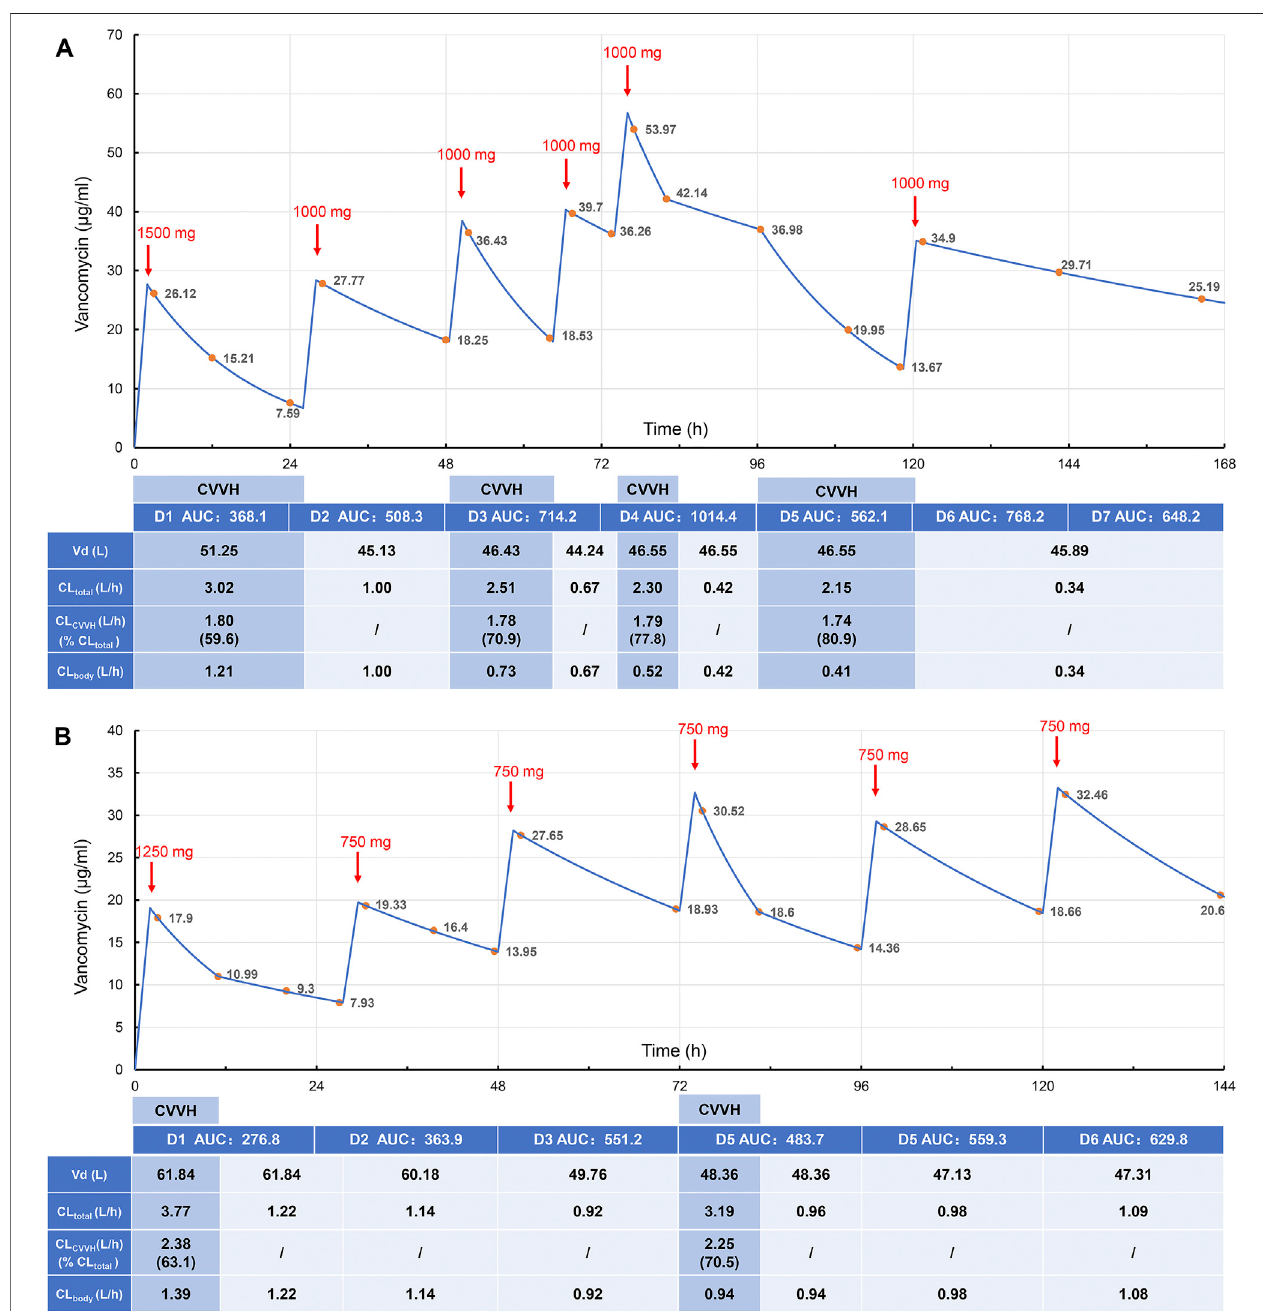
FIGURE 1 | Vancomycin plasma concentration-time curve and pharmacokinetic parameters in case 1 (A) and case 2 (B) . The red arrows indicate the end time of intravenous administration, and the upper numbers indicate the doses. The yellow dots indicate the detected plasma concentrations of vancomycin, and the blue line is the fi ttedplasmaconcentration-timecurve.ThetableshowstheestimatedvancomycinVd,totalclearance,CVVHclearance,endogenousclearance,andAUCofcase1 and case 2 for the corresponding time periods. AUC, area under the time-concentration curve over 24 h, mgh/L; Vd, volume of distribution; CL total , total vancomycin clearance; CL CVVH , CVVH vancomycin clearance; CL body , endogenous vancomycin clearance.